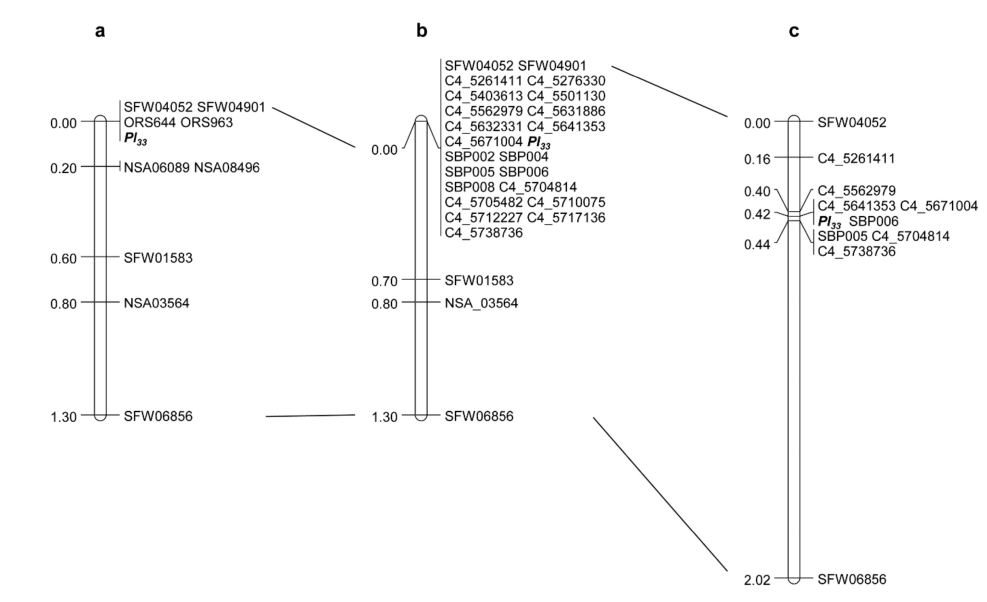
Figure 3. DM Pl 33 gene linkage maps. ( a ) Map taken from Liu et al., 2019 [40], ( b ) Pl 33 saturation map, and ( c ) Pl 33 fine map.